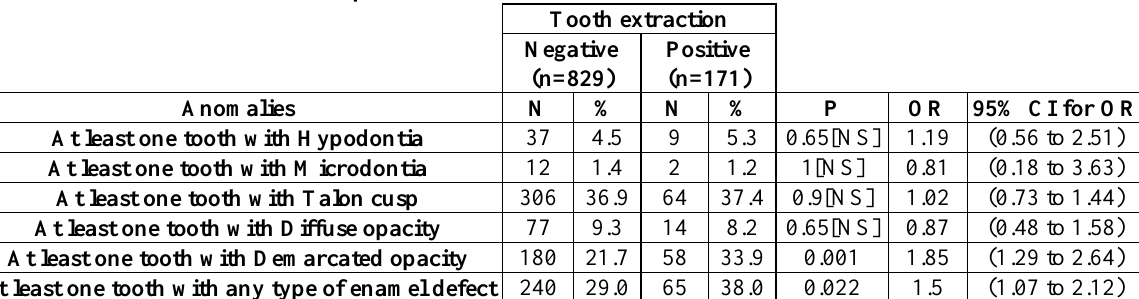
Table 4: The relationship between deciduous tooth extraction and dental anomalies